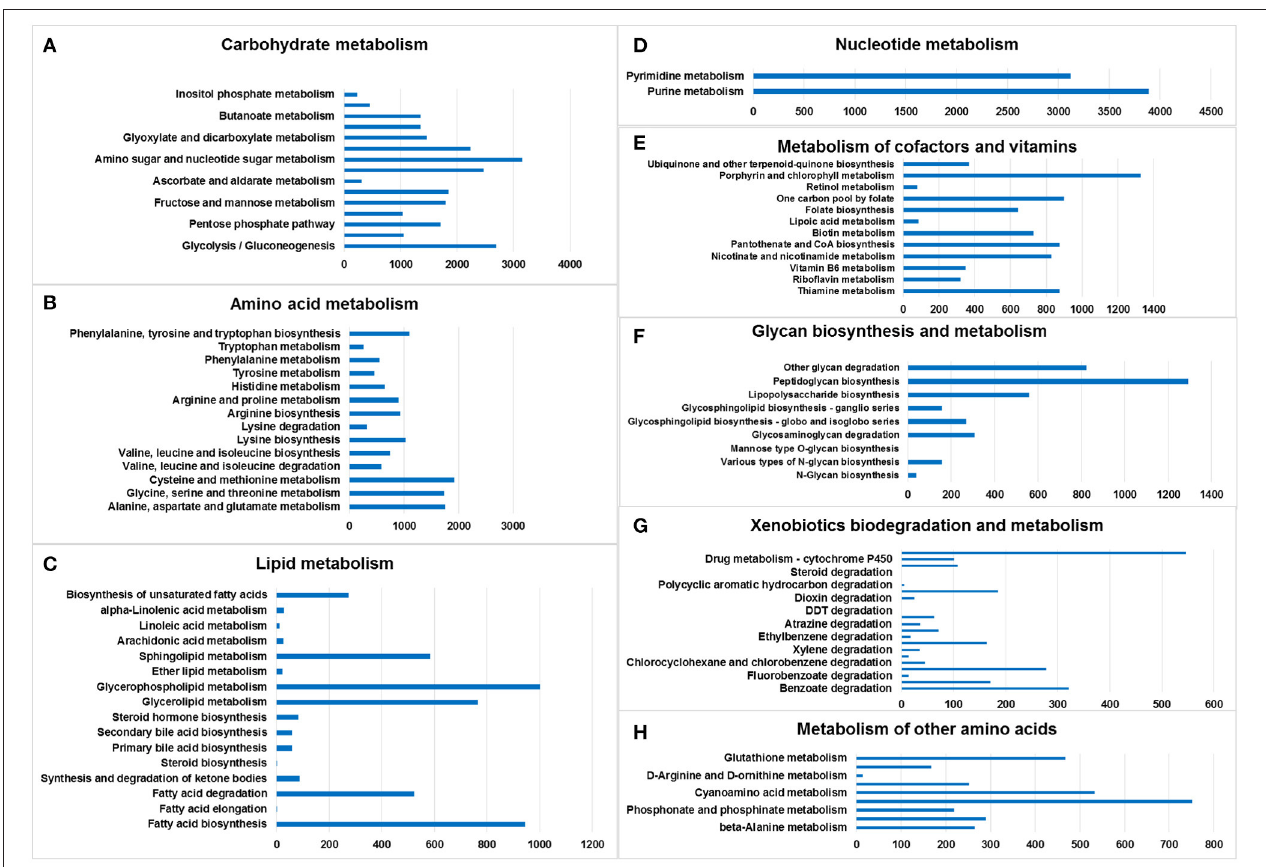
FIGURE 2 | Metabolic pathway analysis of genes. The X-axis shows the numbers of annotated genes in one class, and the Y-axis shows the KEGG functional classes. (A) Carbohydrate metabolism, (B) amino acid metabolism, (C) lipid metabolism, (D) nucleotide metabolism, (E) metabolism of cofactors and vitamins, (F) glycan biosynthesis and metabolism, (G) xenobiotics biodegradation and metabolism, and (H) metabolism of other amino